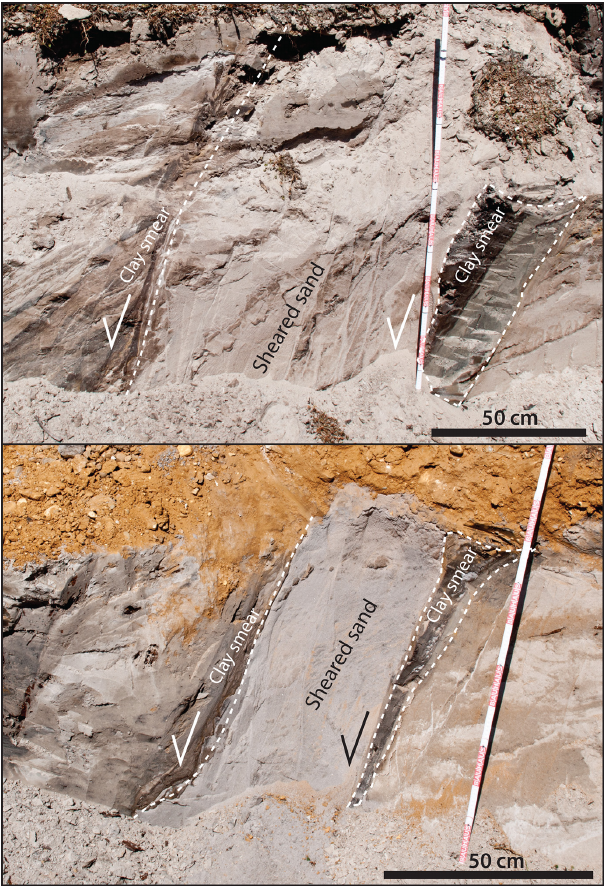
Figure 2. Two vertical sections of the Altdorfer Sprung fault with clay smear in the Inden lignite mine. Displacement is about 15m and the source clays cannot be specified. Distance between both sections is only a few metres. Note the wide shear zone with thick entrained sand layer as well as the variation of clay smear